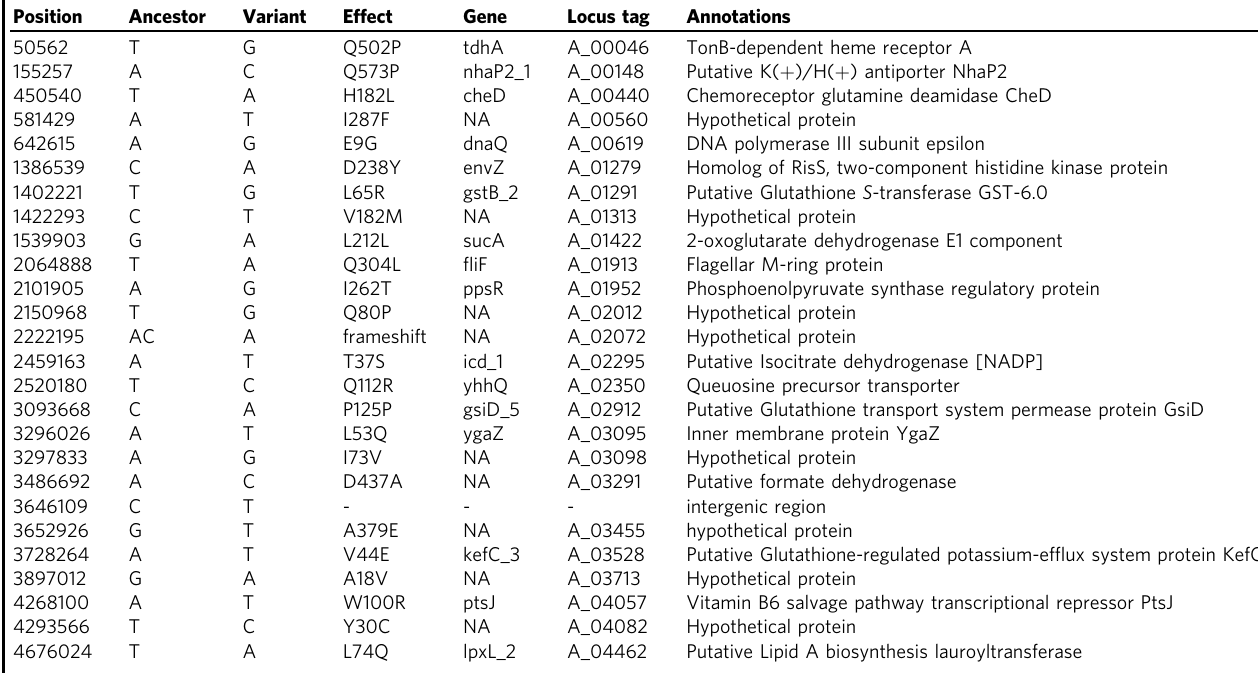
Table 1 Ancestral substitutions common to all highly divergent isolates.